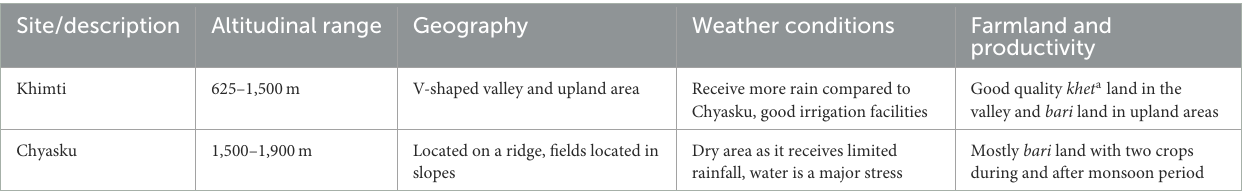
TABLE 1 Key features of two in-depth case study sites.